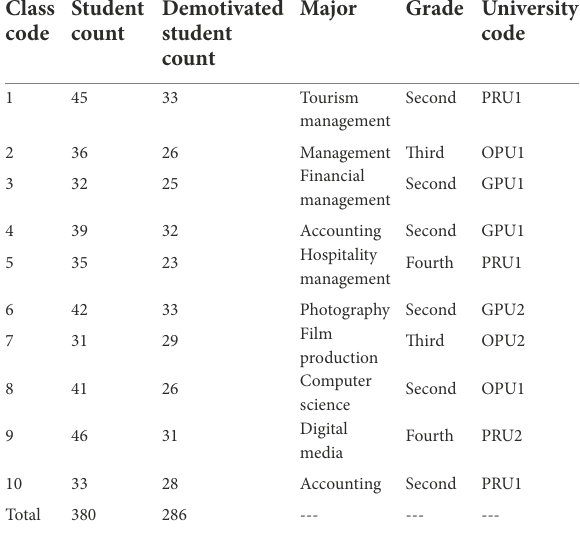
TABLE 1 Interviewees’ basic information. TABLE 2 Information of students filling in